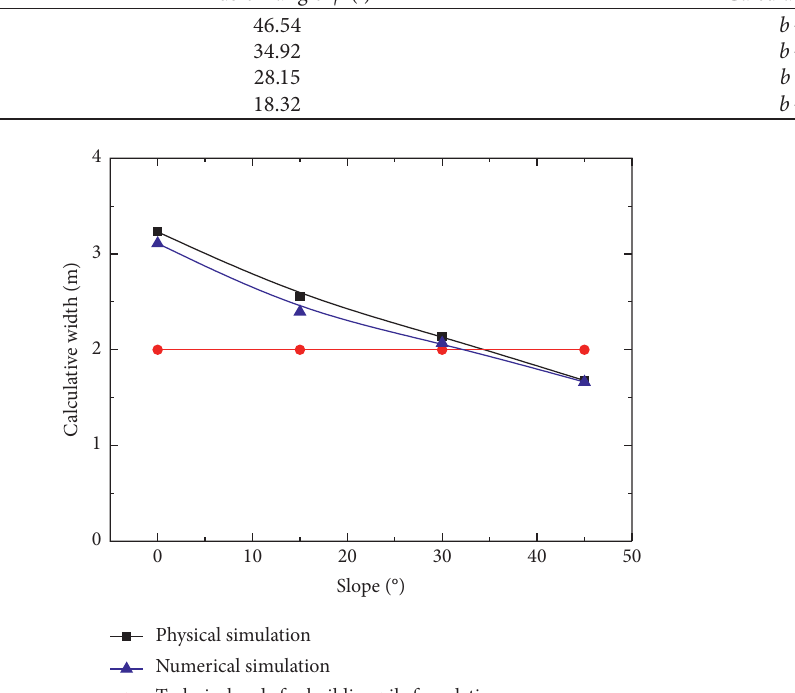
Figure 20: Curve of the calculative width with the